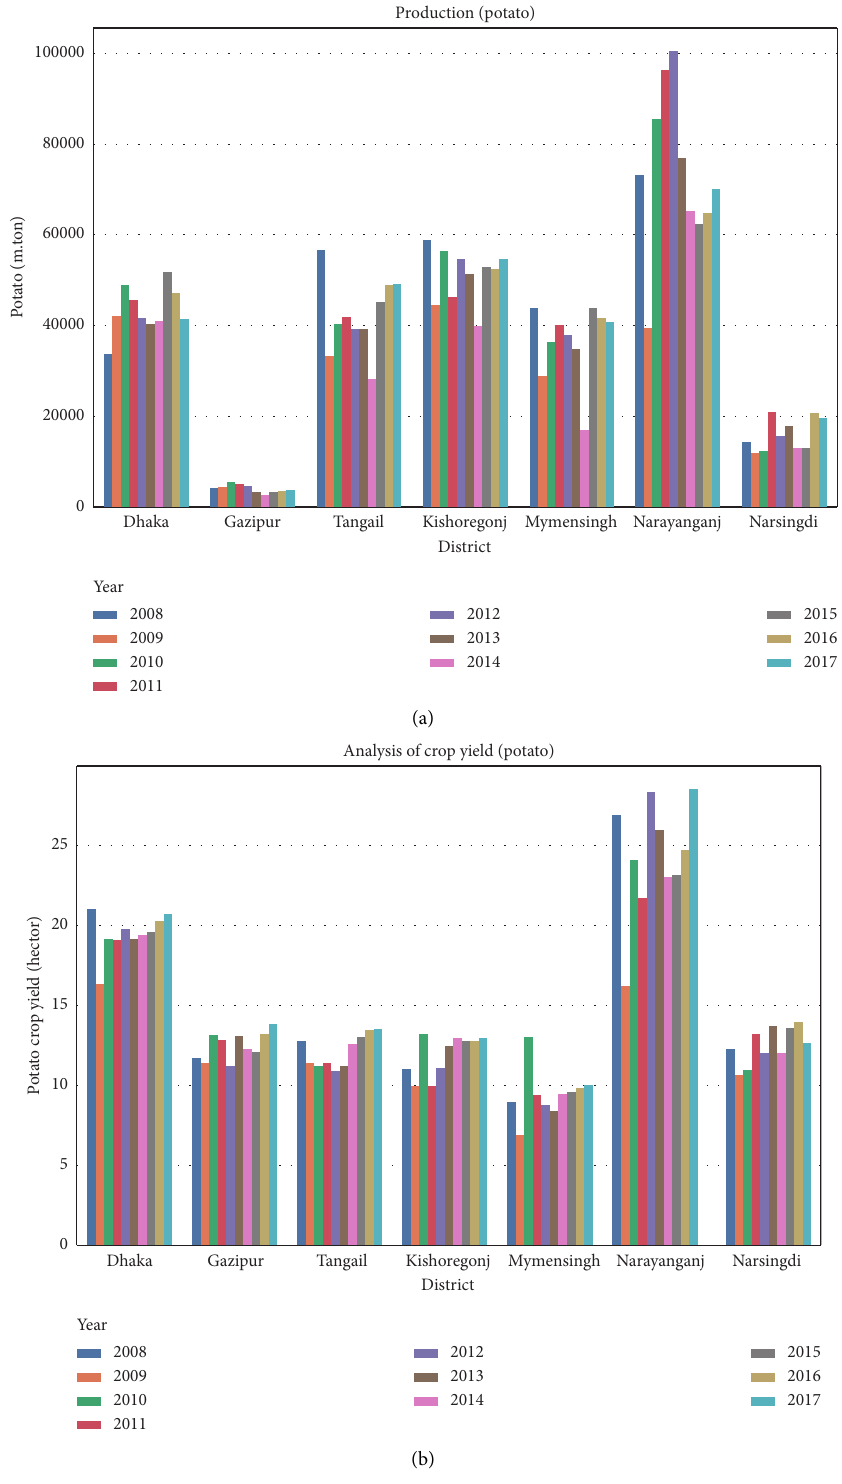
Figure 10: Data analysis of potato. (a) Crop production for potato. (b) Crop yield for